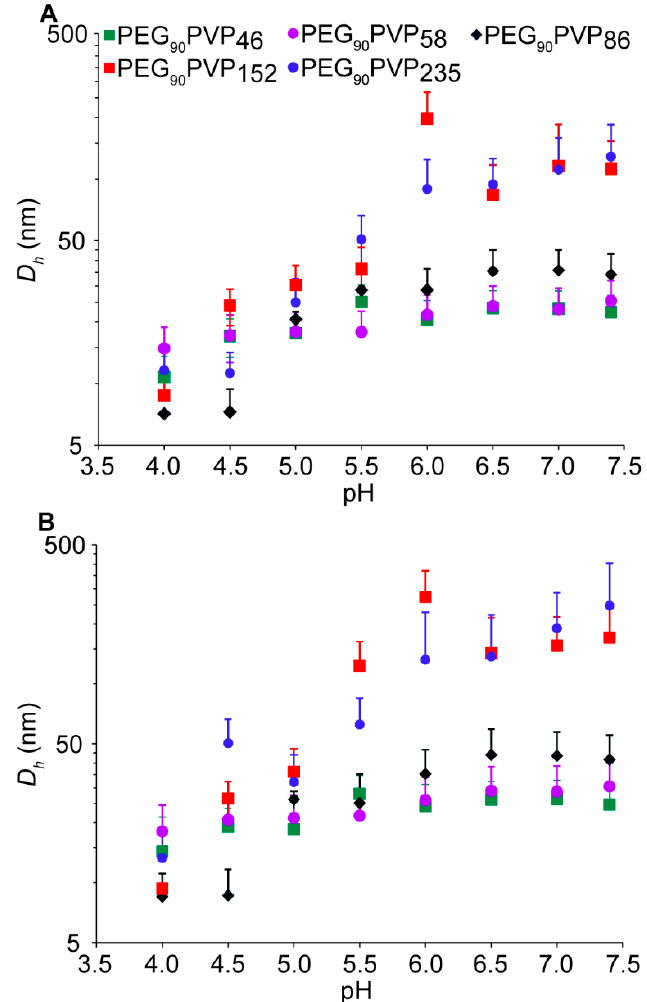
Figure 1. The ( A ) number and ( B ) volume average particle size distributions (PSDs) (Supplementary Materials, Figure S6 and Table S2). Values are reported as mean + std. dev.